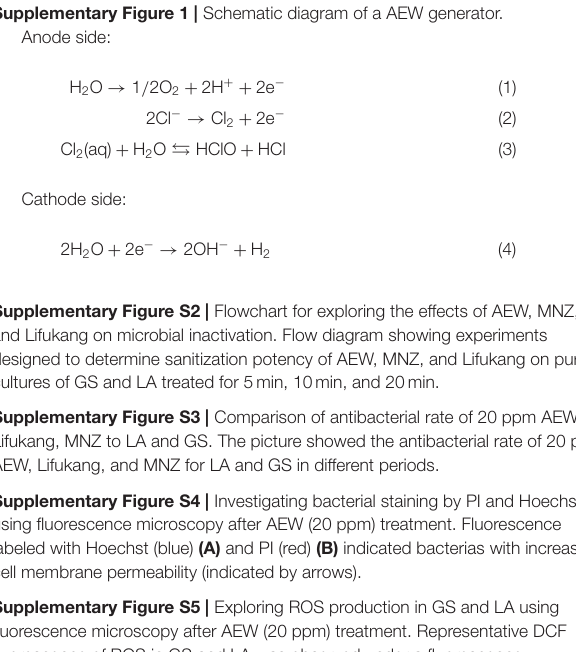
Supplementary Figure 1 | Schematic diagram of a AEW generator. Anode side: